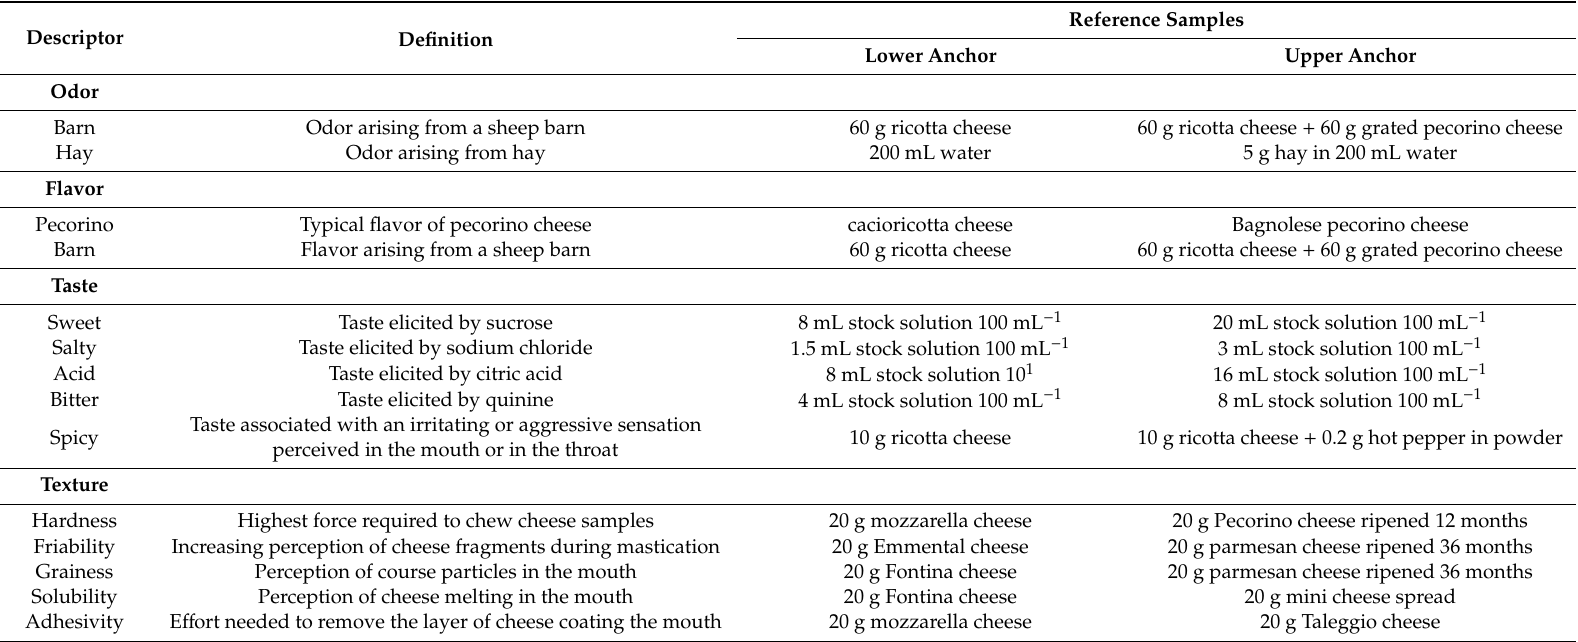
Table 2. List of attributes, definitions, and reference frame used by a 12-member panel for Bagnolese pecorino cheese sensory